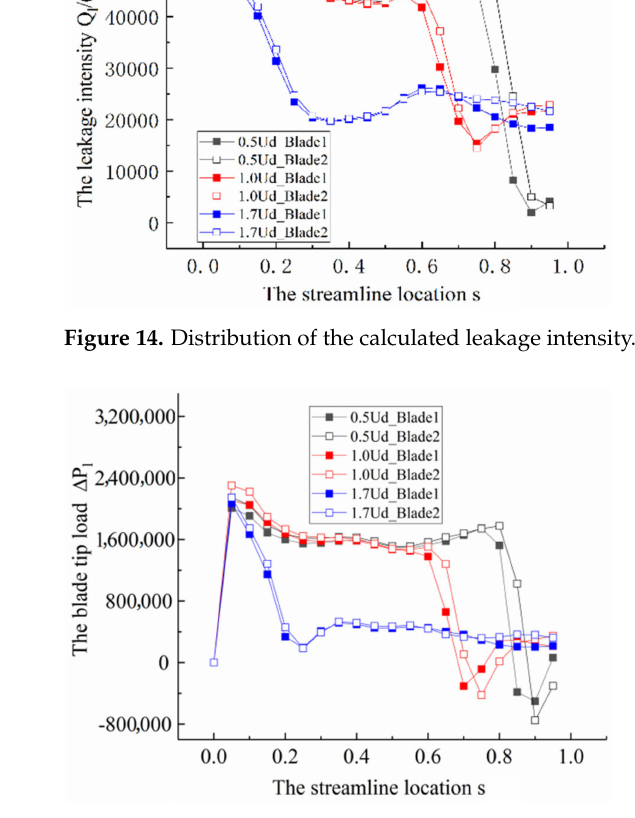
Figure 15. Distribution of the calculated blade load.